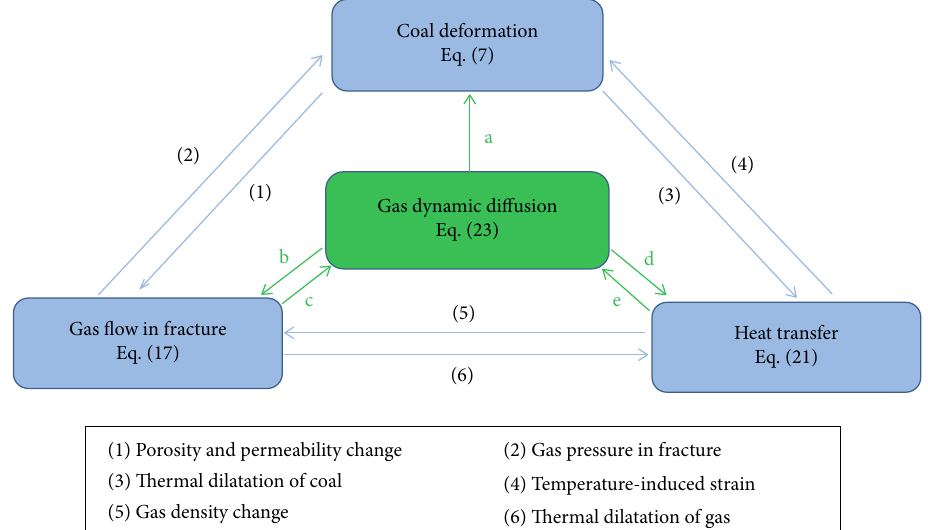
Figure 4: Cross-couplings among multiple physical fi